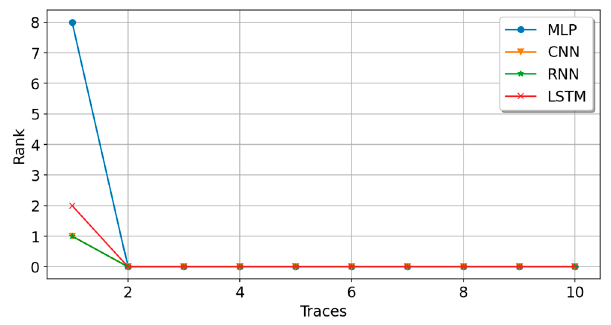
Figure 18. The rank of the the four models.